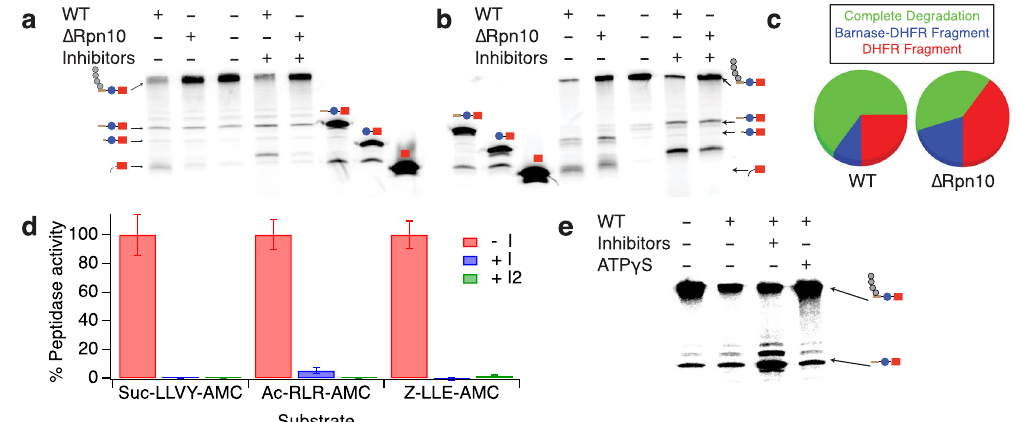
Figure 2. ∆ Rpn10 proteasome has a processivity defect. ( a , b ) Degradation of trace radiolabeled Keap1- ( a ) or Rsp5- ubiquitinated substrate ( b ) by 100 nM wild-type or ∆ Rpn10 proteasome (2 hours). Fragments containing either DHFR plus a small tail or Barnase-DHFR plus a small tail were identified relative to size standard control constructs (Neh2Dual-Barnase-DHFR, Barnase-DHFR and DHFR). Proteasome inhibitors (100 µ M each MG-132, Bortezomib and 1,10-phenanthroline) were added as indicated. Based on quantification, less than 10% of the full-length Keap1-ubiquitinated protein was degraded by ∆ Rpn10 proteasome. Note that similar or greater levels of fragment were formed with ∆ Rpn10 and the Rsp5-ubiquitinated substrate despite a far lesser extent of degradation. ( c ) Quantification (based on two replicate experiments) of the relative frequency of complete versus partial degradation for wild-type versus ∆ Rpn10 proteasome with the Rsp5-ubiquitinated substrate. Protein that did not undergo degradation was ignored. ( d ) Peptidase activity in the absence (red) or presence of proteasome inhibitors as in B (blue; I) or with 100 µ M epoxomicin replacing 1,10-phenanthroline (green; I2). The first cocktail reduces Suc-LLVY- AMC (chymotrypsin-like) activity to 0.1% (p = 0.07 when comparing proteasome plus inhibitors to background reaction), reduces Ac-RLR-AMC (trypsin-like) activity to 5% of uninhibited rates (p = 0.001), and eliminates Z-LLE-AMC (peptidyl glutamyl hydrolase-like) activity (at or below background rates). With the second cocktail, all rates are indistinguishable from background. Error bars are the SEM of 4 replicate assays. ( e ) Degradation of trace radiolabeled Keap1-ubiquitinated substrate by 100 nM wild-type proteasome pretreated for 15 minutes with 100 µ M each MG-132, Bortezomib, and epoxomicin or 1 mM ATP γ S. No NADPH was added to stabilize DHFR in this experiment. Full-length gels are presented in Supplementary Fig.